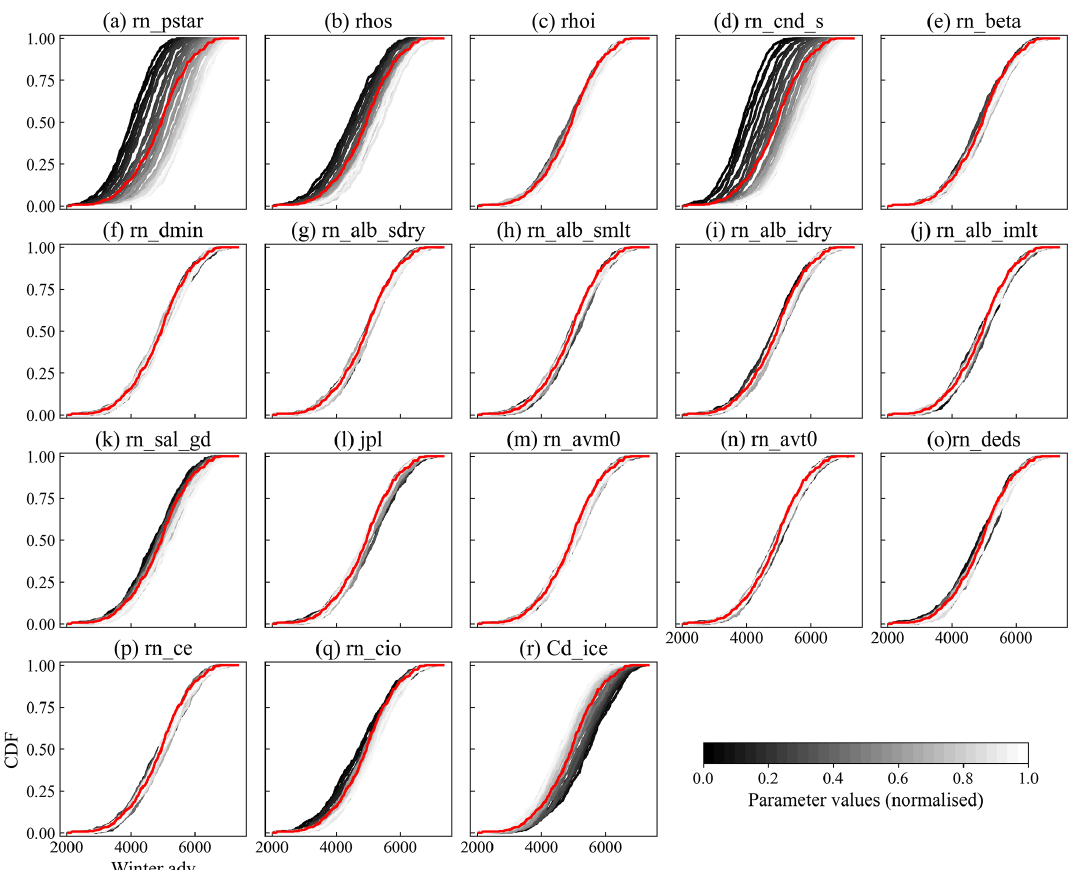
Figure 12. The same as Fig. 11 but for the area integral of the adv component of the winter SIV budget. The units of the x axis are 10 3 km 3